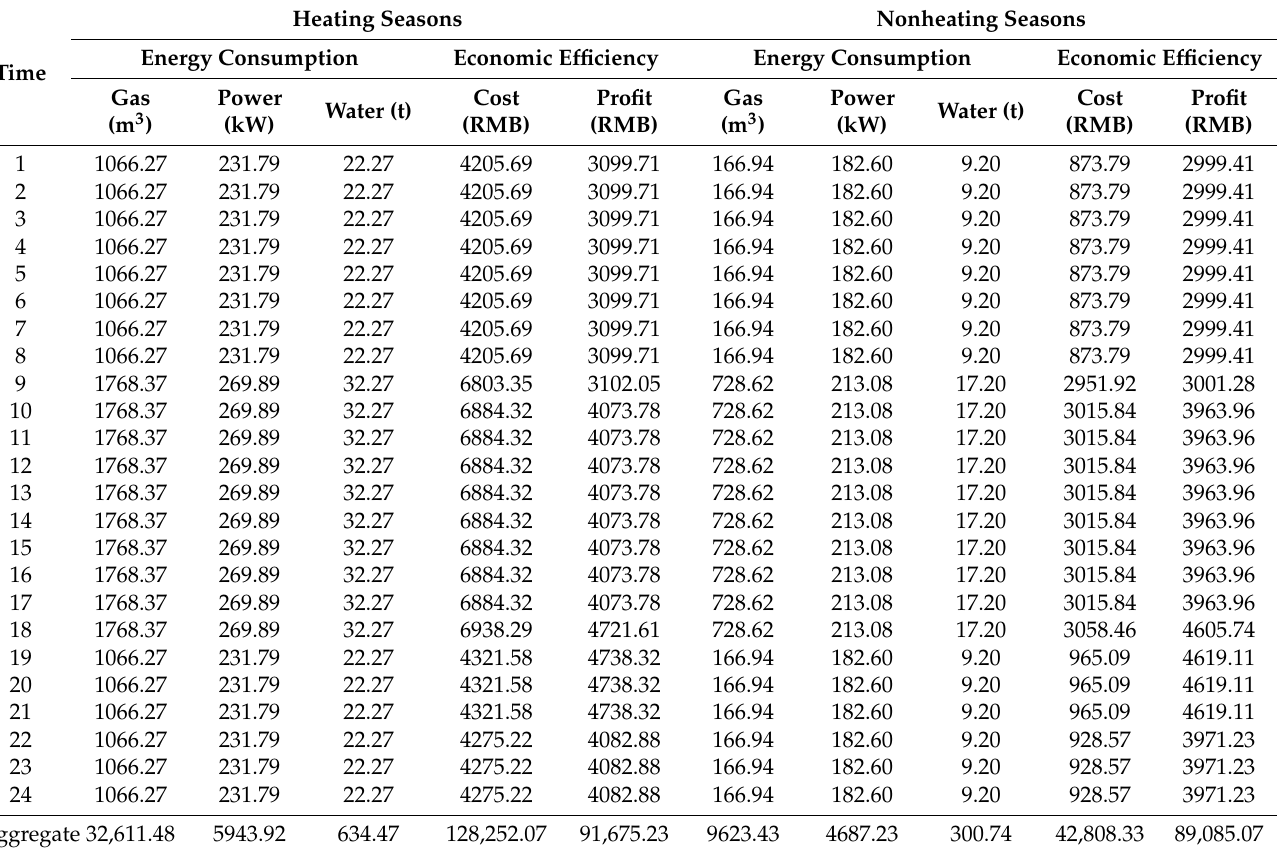
Table 2. Energy consumption and economic performance of the CHP system over two seasons.